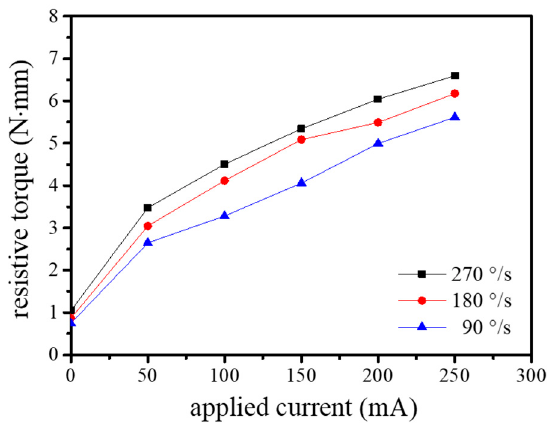
Figure 9. Experimental setup of the proposed actuator.